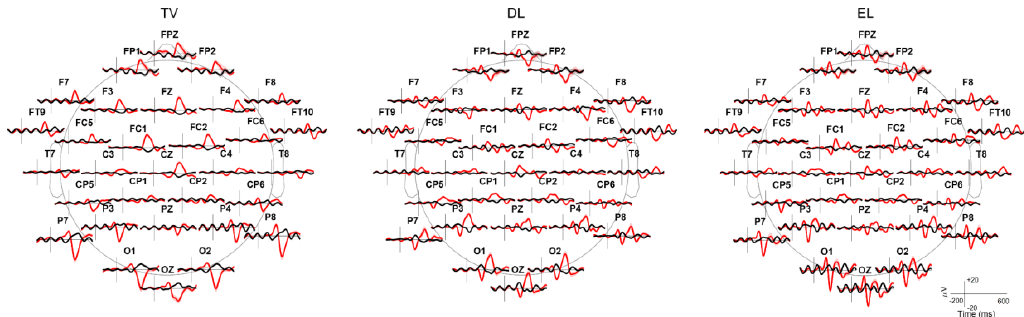
Figure 2. Grand average event-related potentials (ERPs) across all subjects of all (EEG) channels for TV, DL, and EL. Solid red lines indicate the target ERP and solid dark lines denote electroencephalography (EEG) channels for TV, DL, and EL. Solid red lines indicate the target ERP average of three non-target ERPs. and solid dark lines denote average of three non-target ERPs.